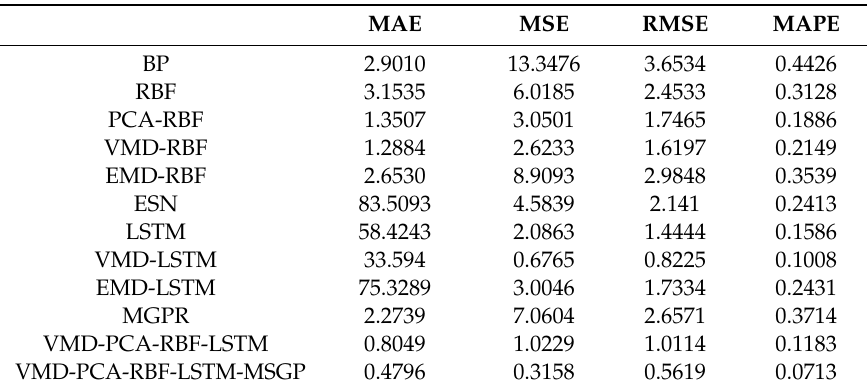
Figure 16. The results of hybrid models (VMD-PRBF-LSTM-VMD-PRBF-LSTM-MGPR). Table 2. Analysis table of point prediction evaluation index.